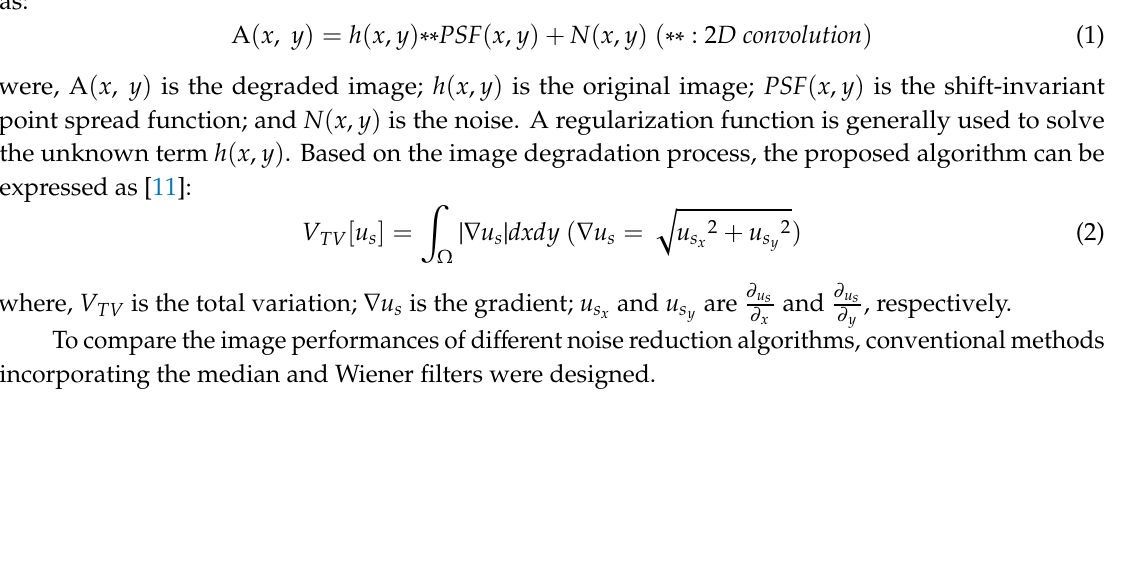
microscopy (CLSM) imaging. 97